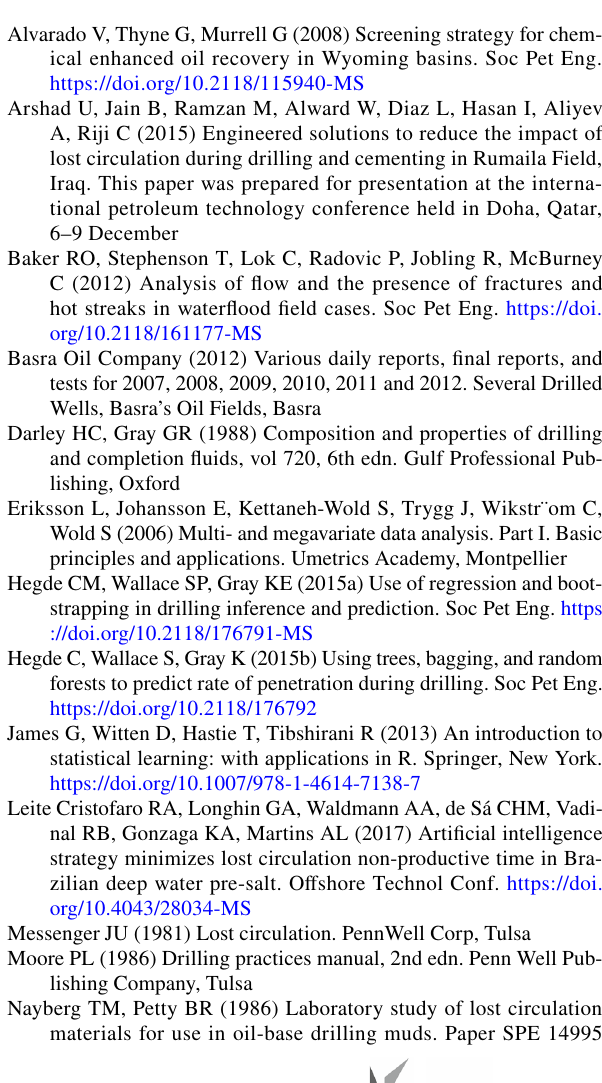
Fig. 37 Predicted versus actual ROP for severe and complete